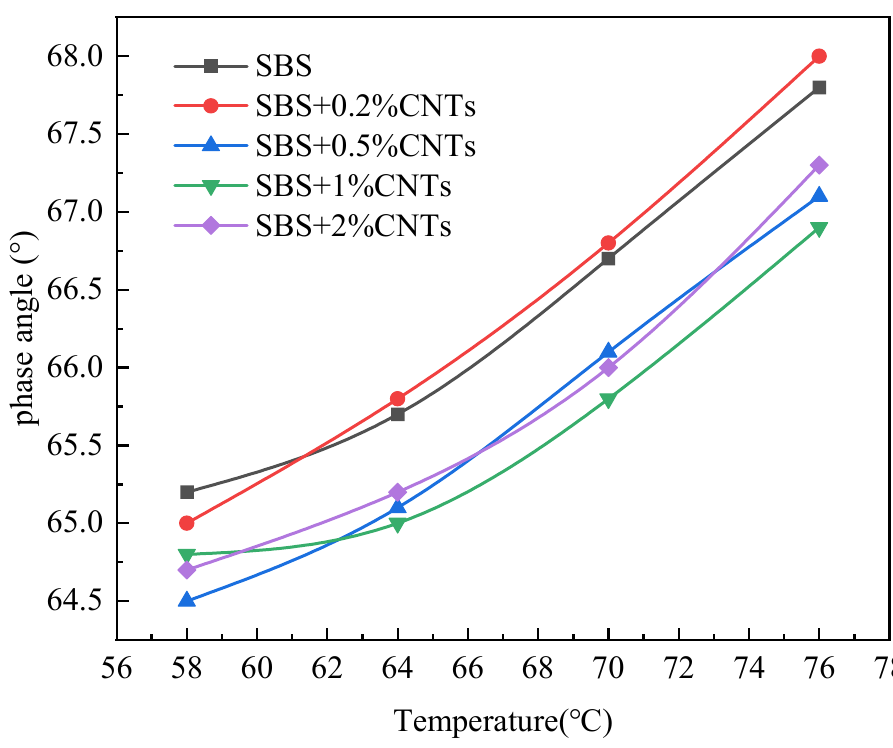
Figure 4. Phase angle after UV aging.